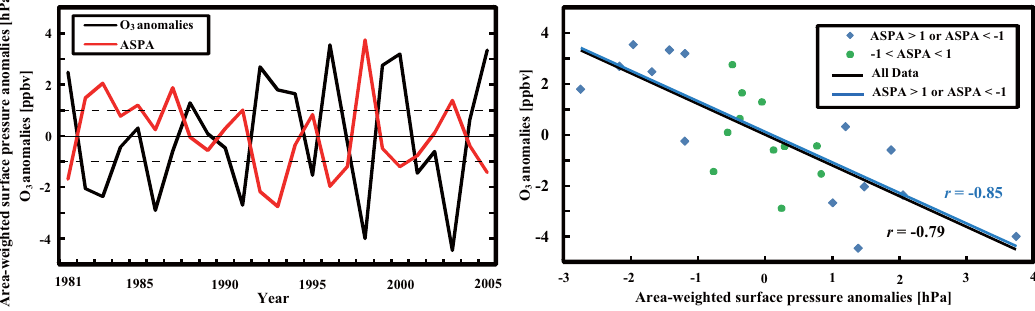
Fig. 7. Time series (left) and scatter plot (right) of springtime BL O 3 anomalies and ASPA during 1981–2005. Horizontal dashed lines indicate ± 1hPa of ASPA. Blue and green points respectively represent absolute values of ASPA larger (large ASPA data; 14 data points) and smaller (11 data points) than 1hPa. The black regression line is for all data (25 data points), and the blue one is for large ASPA data. The simulation scenario and the definition of anomalies are the same as in Fig. 6.